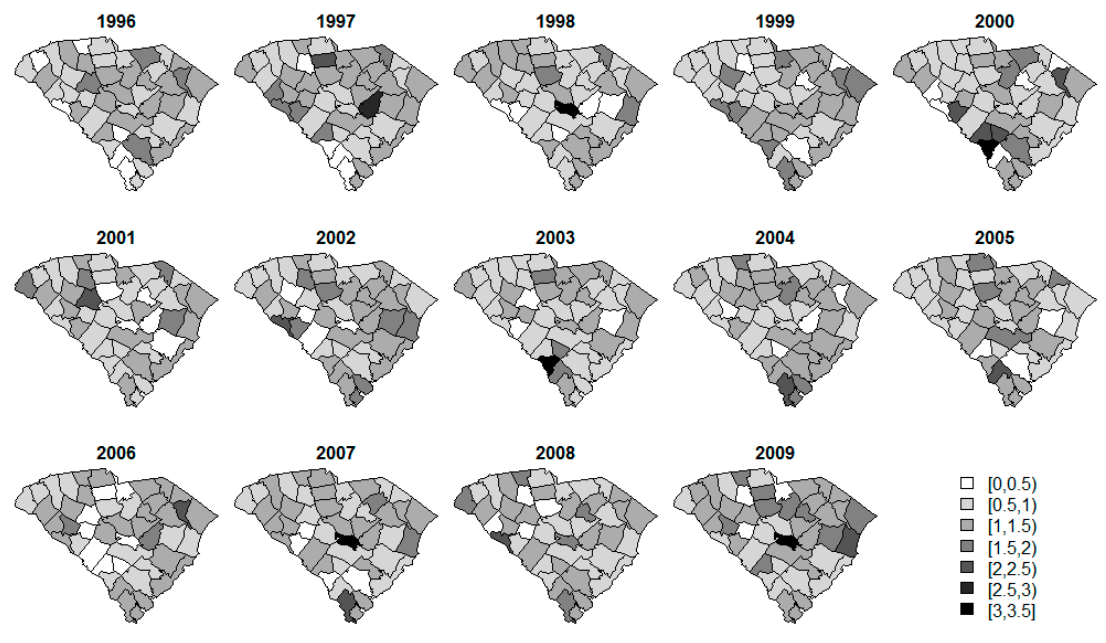
Figure 2. SIR of oral cavity and pharynx cancer.